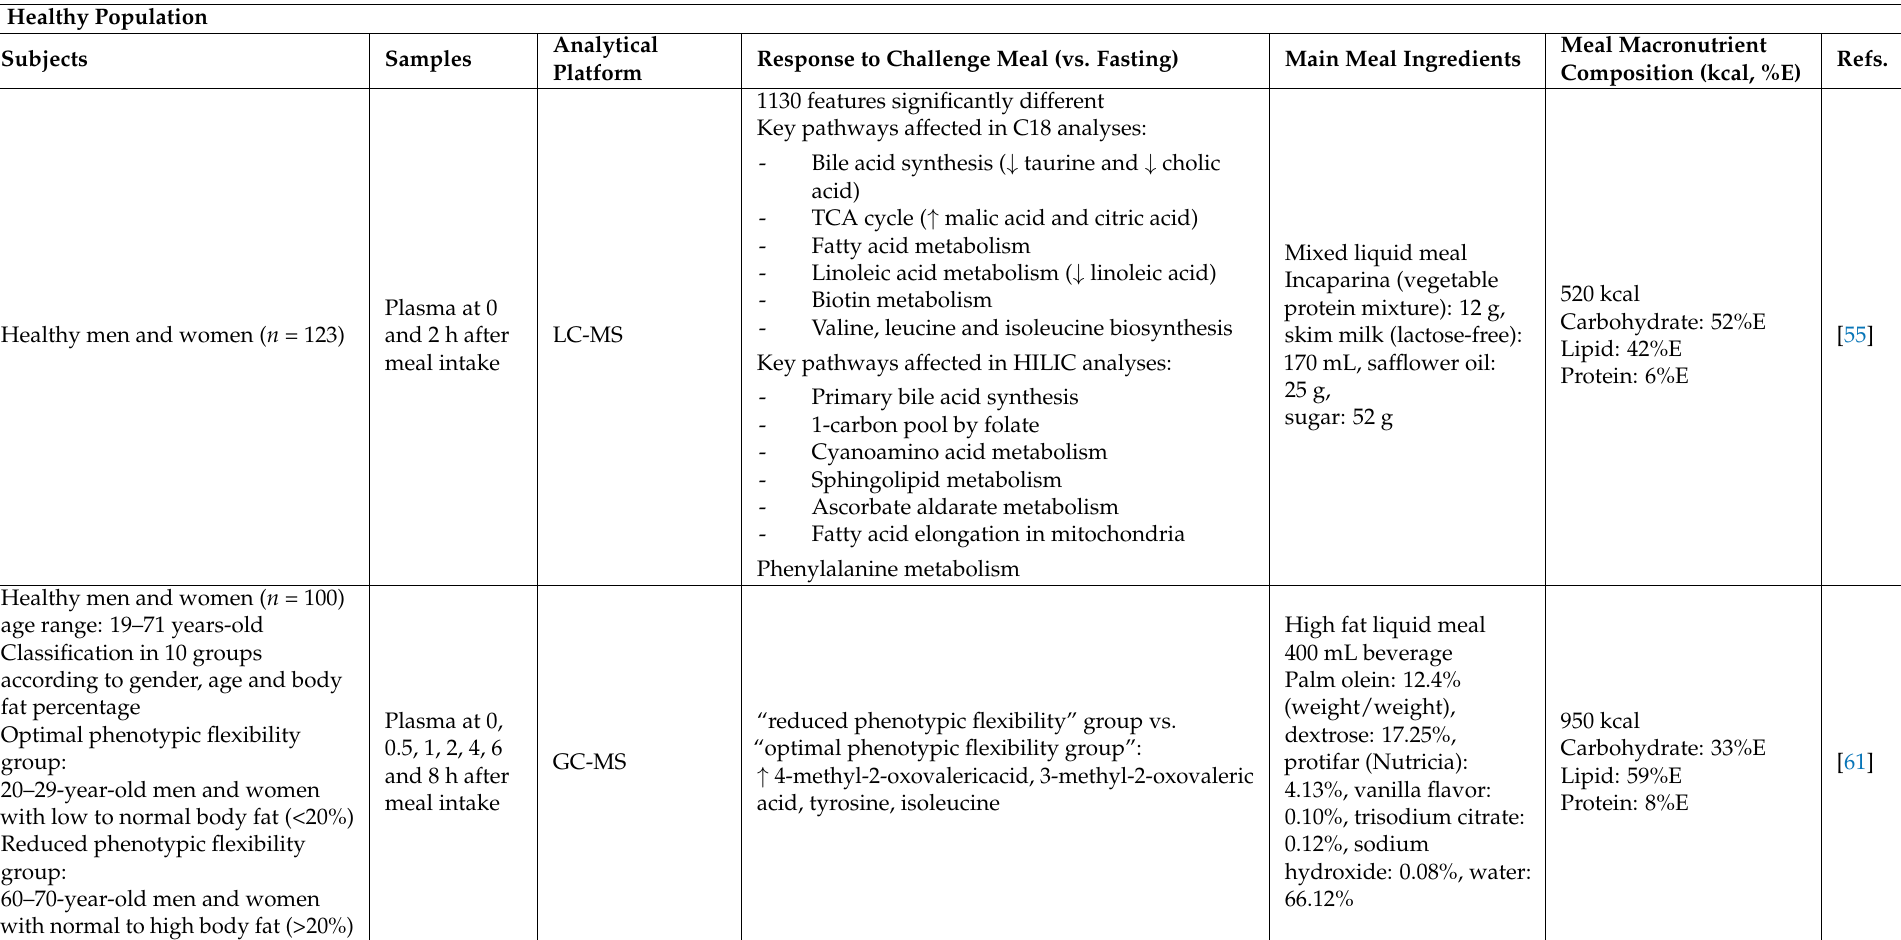
Table 2. Summary of reviewed studies investigating the mixed meal response in healthy individuals with a metabolomics